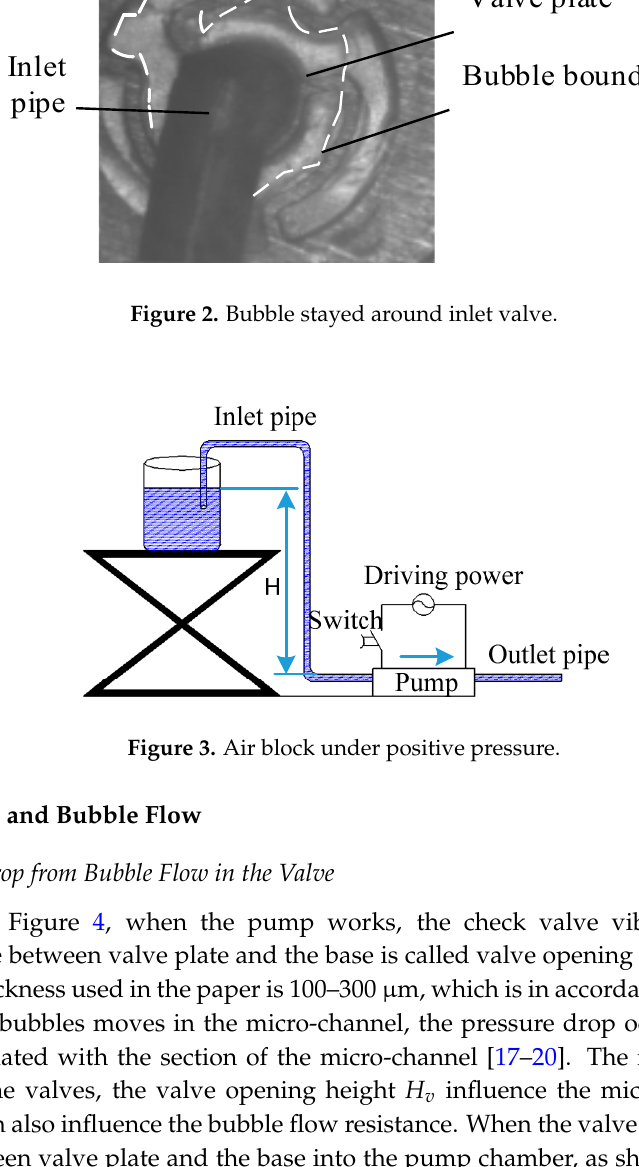
Figure 4. Bubble through valve plate.